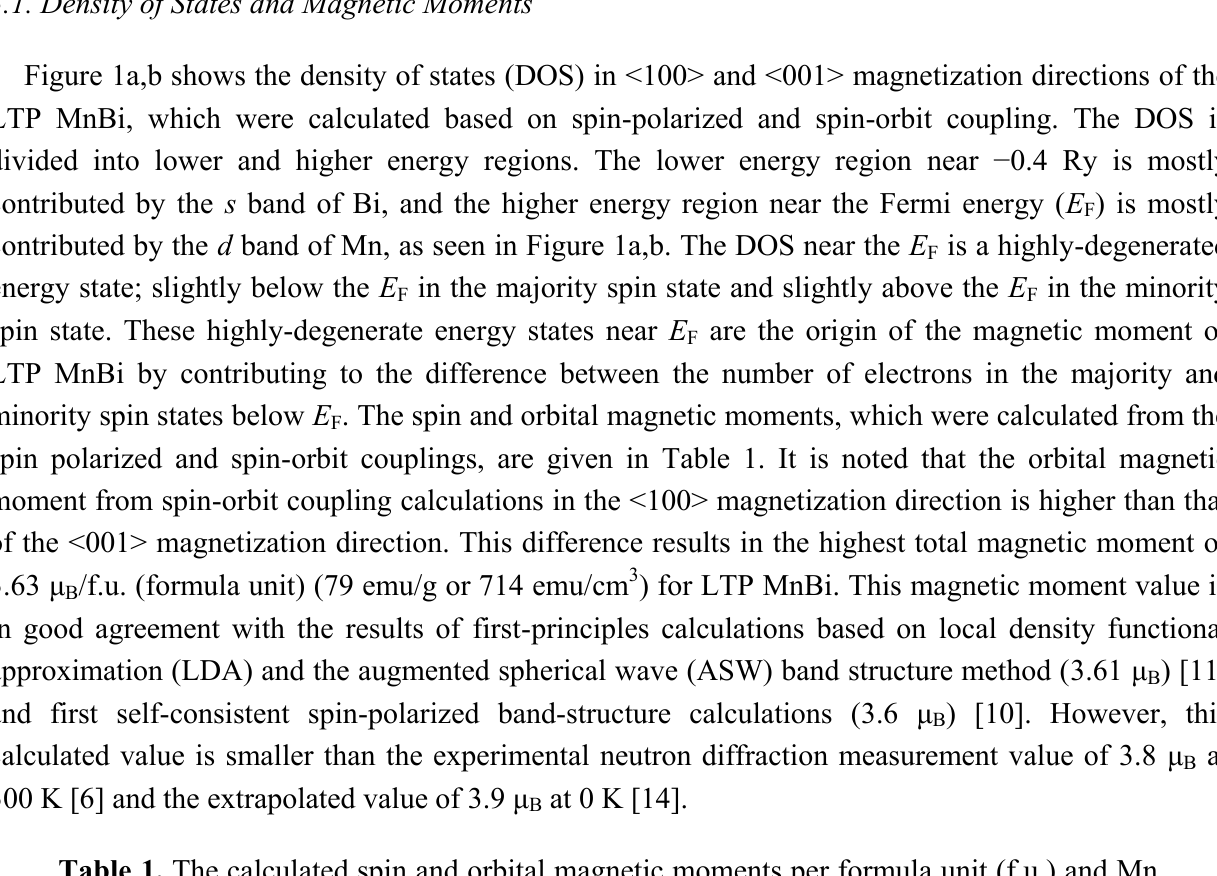
. Magnetic moments B